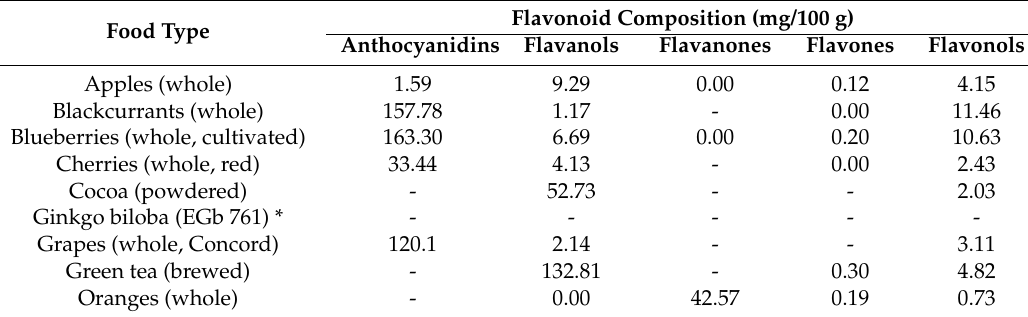
Table 2. Average flavonoid compositions for different food